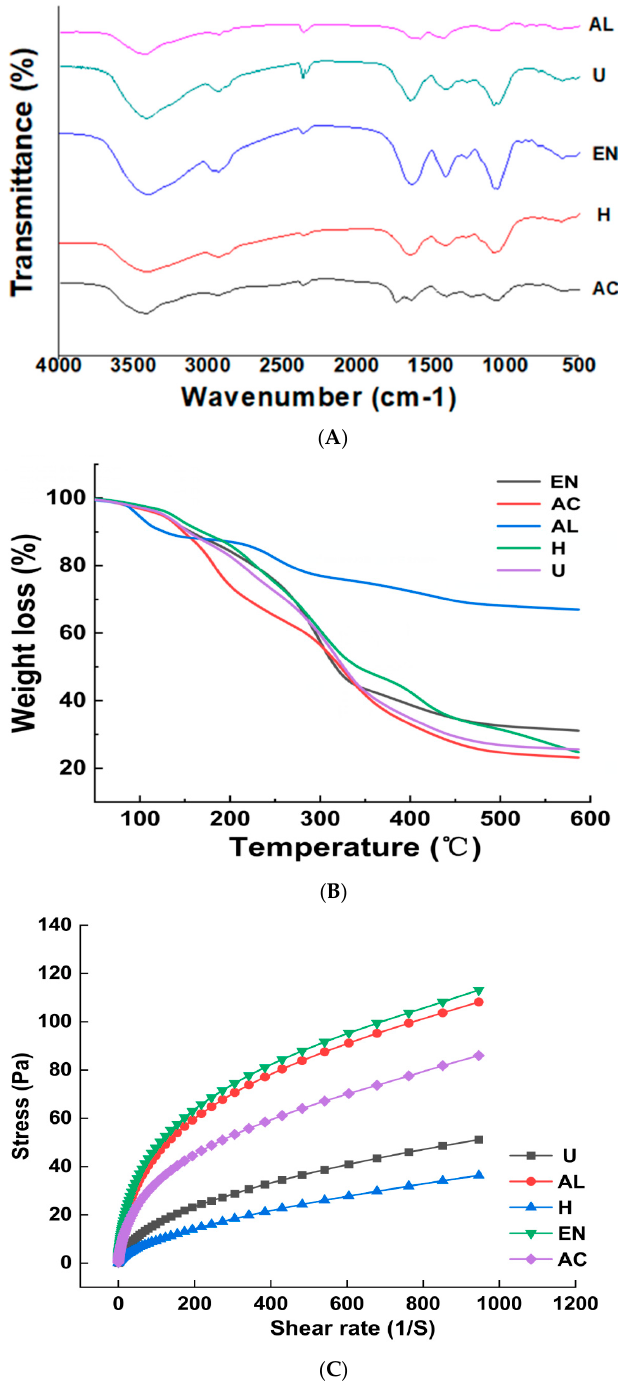
Figure 2. FT − IR spectra ( A ) thermal properties ( B ) and rheogram plot ( C ) for Sanchi flower. AC, Acid; AL, Alkali; EN, Enzyme; Homogenization, H; U, Ultrasonication.